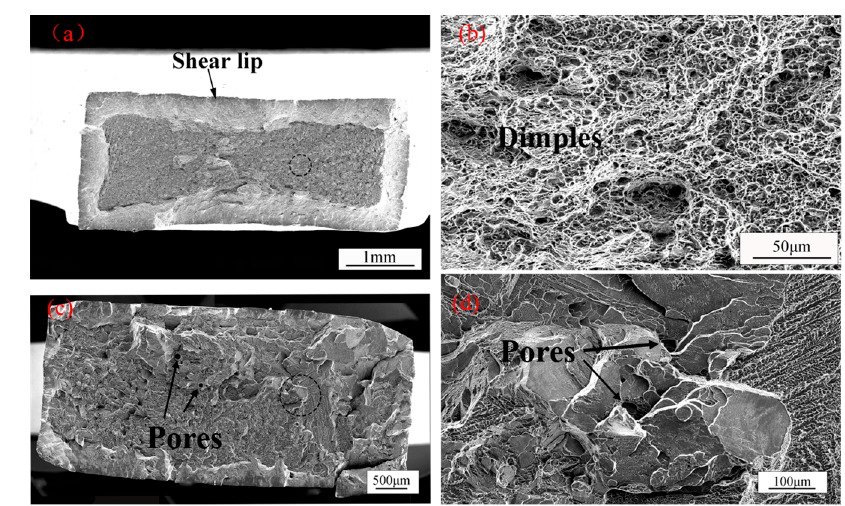
Figure 6. The tensile fractures of TC17 alloy EBW joints, ( a ) BM of the fracture of PWHT TC17 EBW joint, ( b ) BM of the fracture of PWHT TC17 EBW joint enlarged view, ( c ) FZ of as ‐ welded TC17 EBW joint fracture, ( d ) FZ of as ‐ welded TC17 EBW joint fracture part enlarged view.